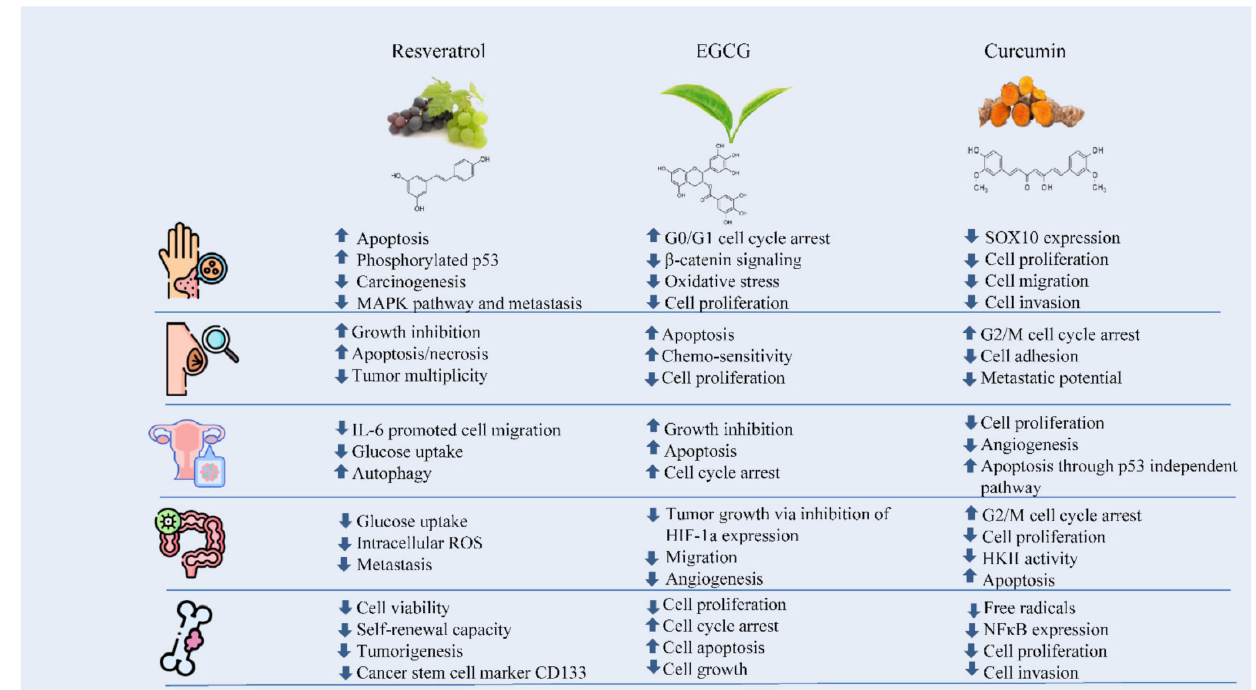
Figure 4. The effects of polyphenols against skin, breast, ovarian, colorectal, and bone